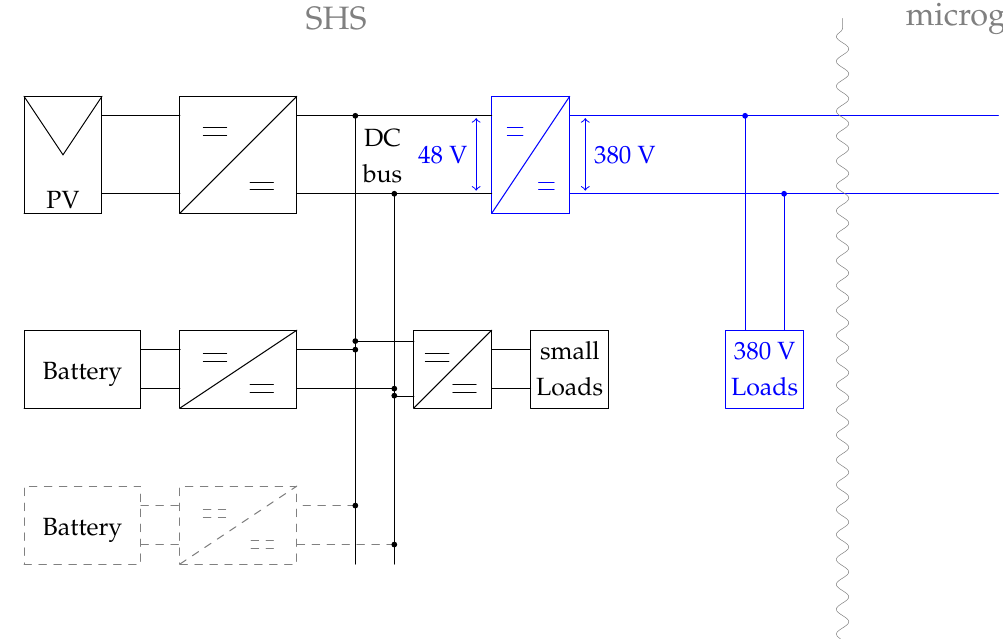
Figure 3. Modular DC architecture for an SHS-based DC microgrid that enables intra-household growth option as well as scalability in the form of a meshed DC microgrid. Dashed battery with converter illustrates the modular capability. Similar modular expandability can be considered for loads and PV